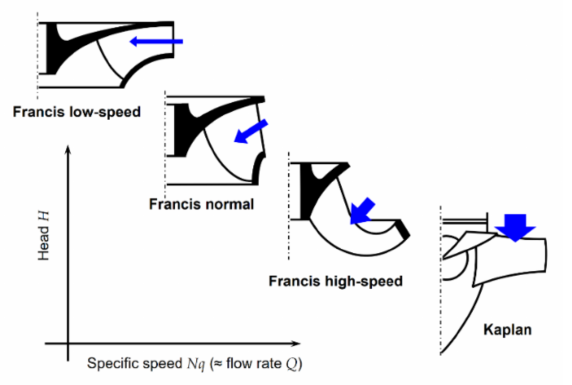
Figure 1. Impeller shapes depending on the hydrotechnic